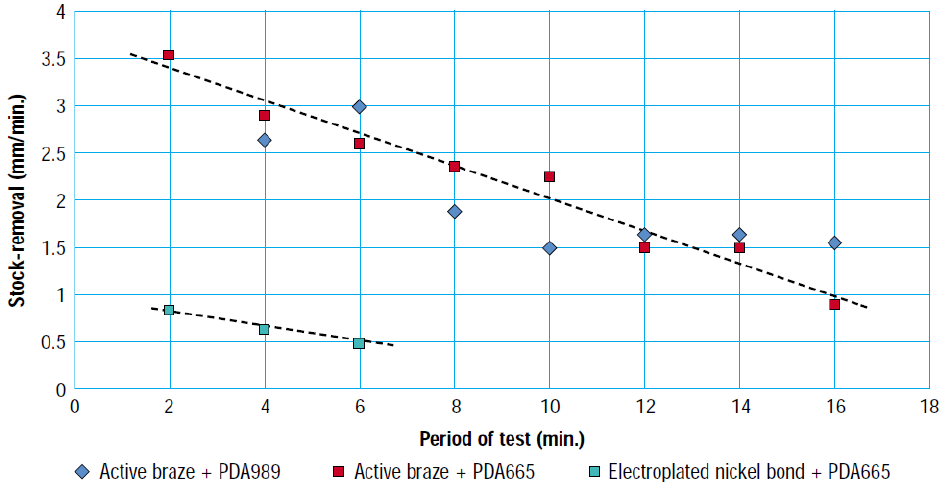
Figure 9. Comparison of stock-removal with electroplated and brazed pencil grinders [22].